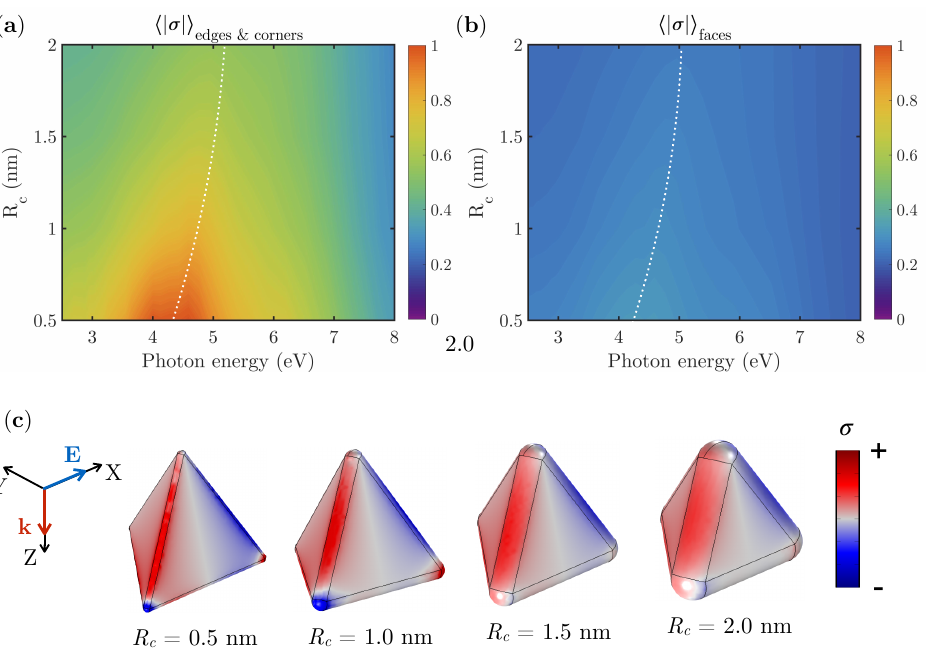
Figure 5. ( a ) Normalized spectral values of surface charge distribution ( σ ) averaged over edges and corners and ( b ) the flat faces of the TDs with rounded edges and corners as function of the curvature radii R c . ( c ) Surface charge distribution ( σ ) over Rh TDs with rounded edges and corners with a curvature radii R c when illuminated at the resonant wavelength. The red/blue regions represent positive/negative charge